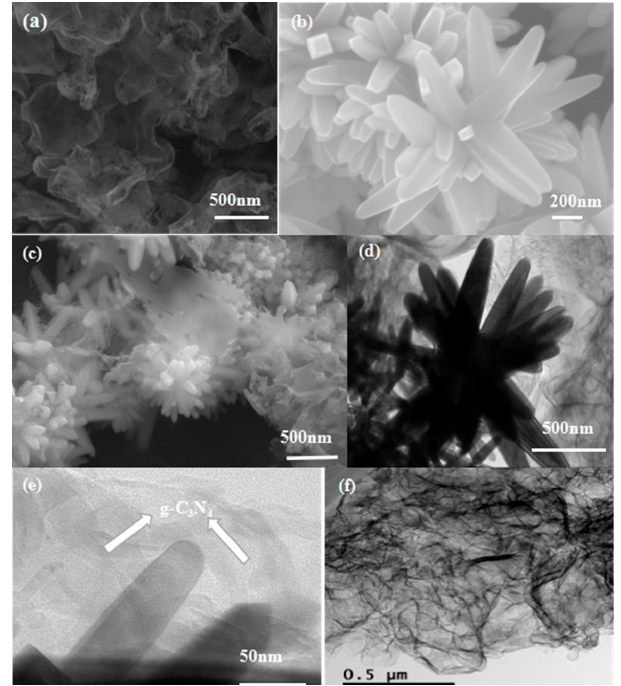
Figure 2. Field-emission scanning electron microscopy ( FESEM) images of pure g-C 3 N 4 ( a ); SnO 2 flower-like nanorods ( b ); SnO 2 /g-C 3 N 4 nanocomposite ( c ); and transmission electron microscopy (TEM) images of the SnO 2 /g-C 3 N 4 composite ( d , e ) and pure g-C 3 N 4 ( f ).